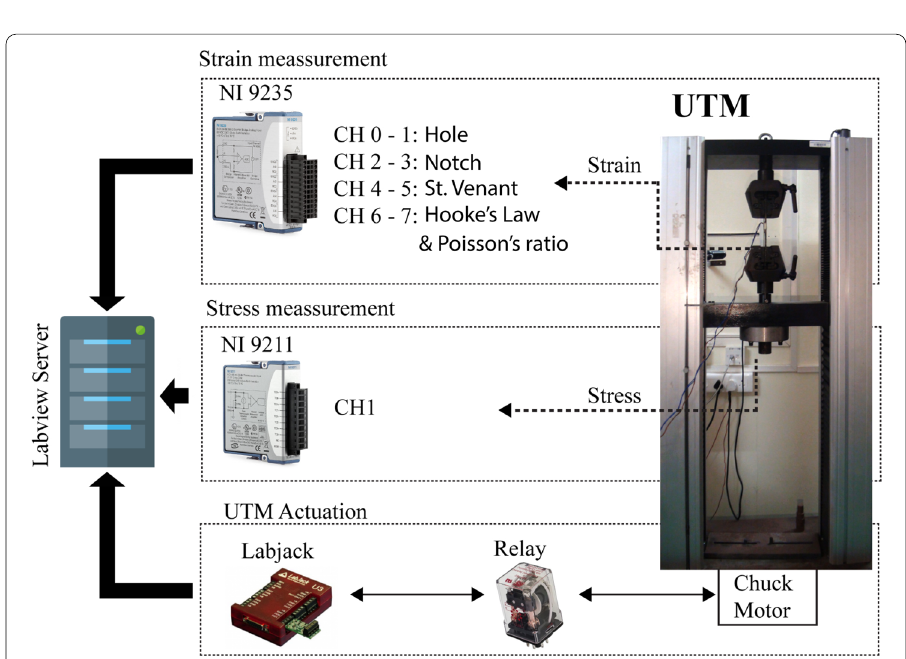
Fig. 5 Schematic representation of instrumentation